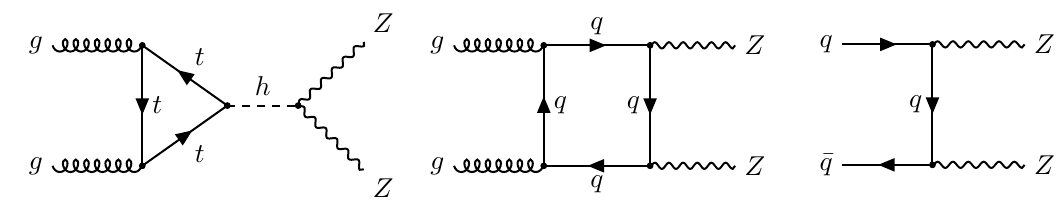
Figure 2. SM contributions to pp → ZZ . The left, centre and right Feynman diagram represents a LO contribution to the gg → h ∗ → ZZ , gg → ZZ and q ¯ q → ZZ channel, respectively. In the case of the left graph there are also contributions involving bottom quarks. These diagrams are included in our analysis. See the text for additional